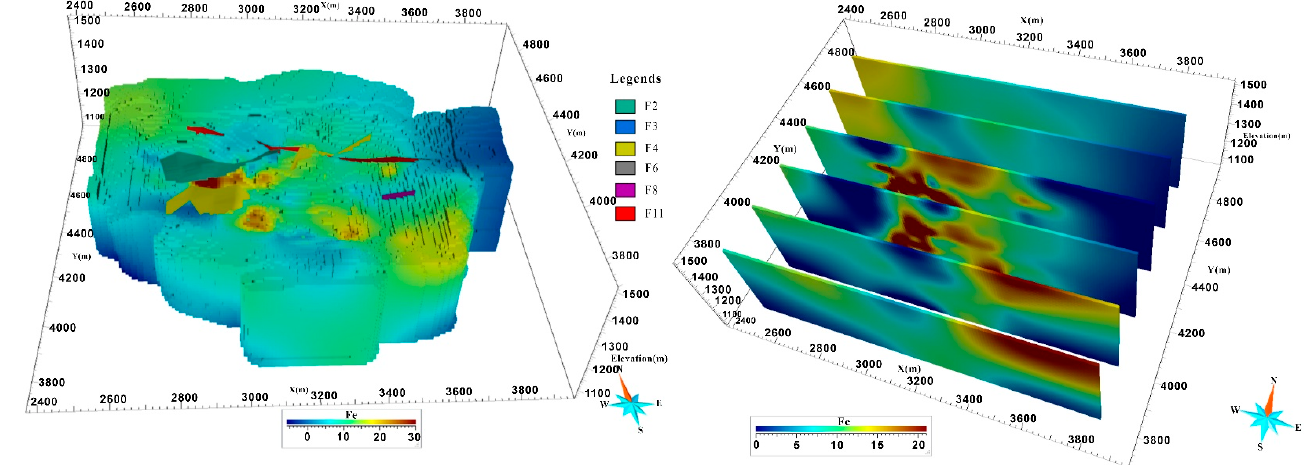
Figure 10. 3D grade model of Fe orebodies.